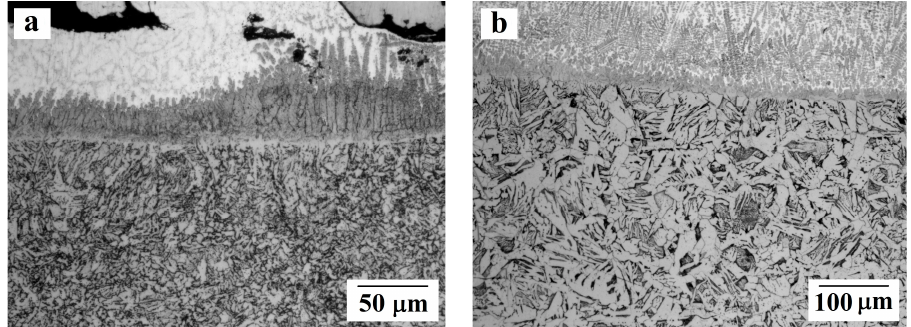
Figure 6. The HAZ microstructure (according to optical microscopy) for samples: ( a ) No. 1; ( b ) No. 5.